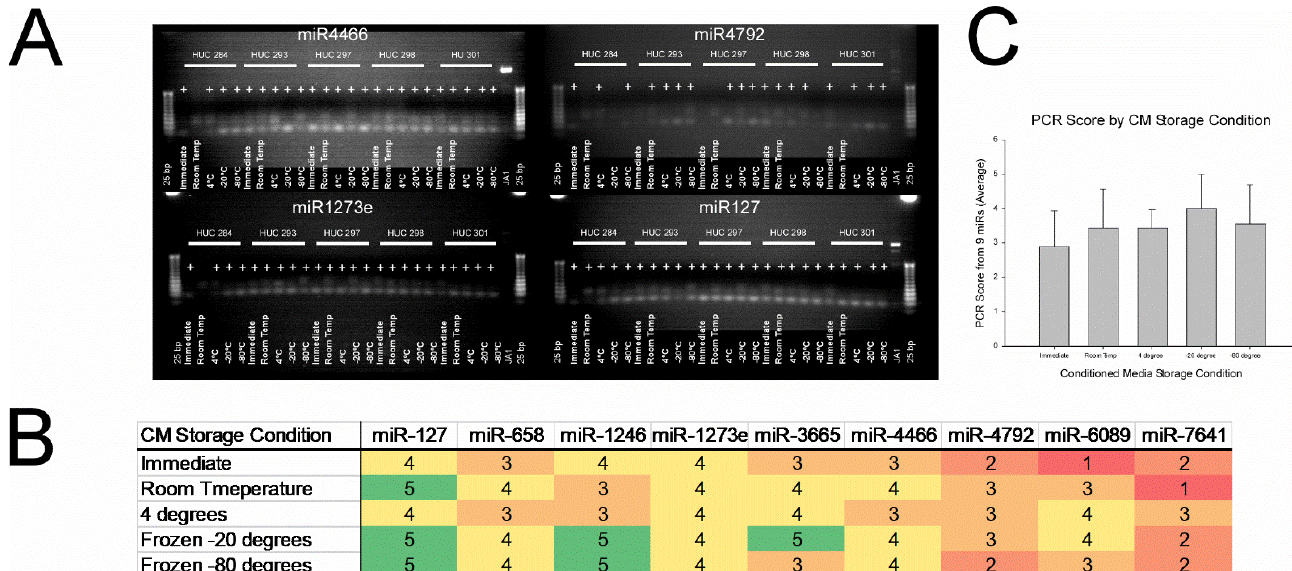
Figure 7. Total microRNA yield (µg/mL) from extracellular vesicles isolated from human umbilical cord-derived mesenchymal stromal cell conditioned media immediately or stored at room temper- ature, 4 °C, -20 °C, or -80 °C. The trend was for RNA from CM stored at 4 °C to have the smallest yield (18.3 µg/mL). Yields from immediate (30.5 µg/mL), room temperature (25.7 µg/mL), -20 °C (28.1 µg/mL), and -80 °C (24.8 µg/mL) were consistent. No significant differences were noted ( p = 0.07). Data are presented as mean ± standard deviation, n = 5.